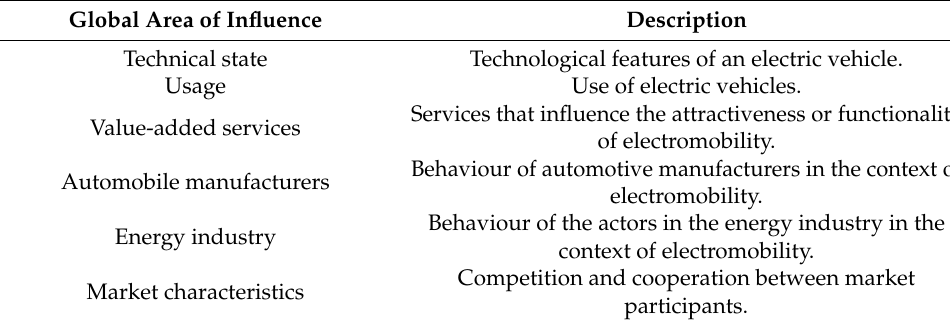
Table 2. Local areas that influence